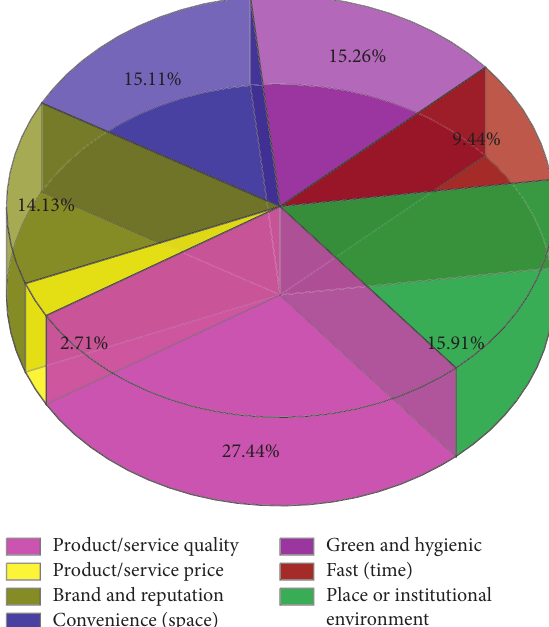
Figure 6: Consideration